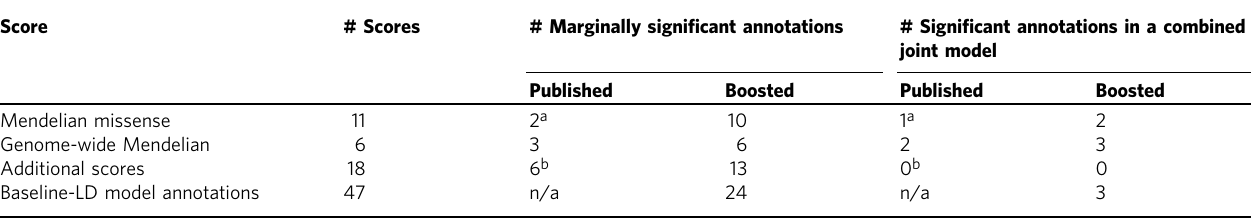
Table 2 Summary of informativeness for a common disease of annotations derived from 82 published scores and corresponding boosted